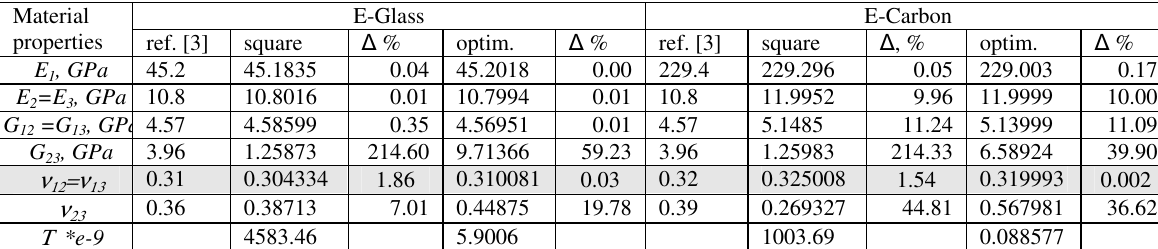
Table 7. Results of identification of material